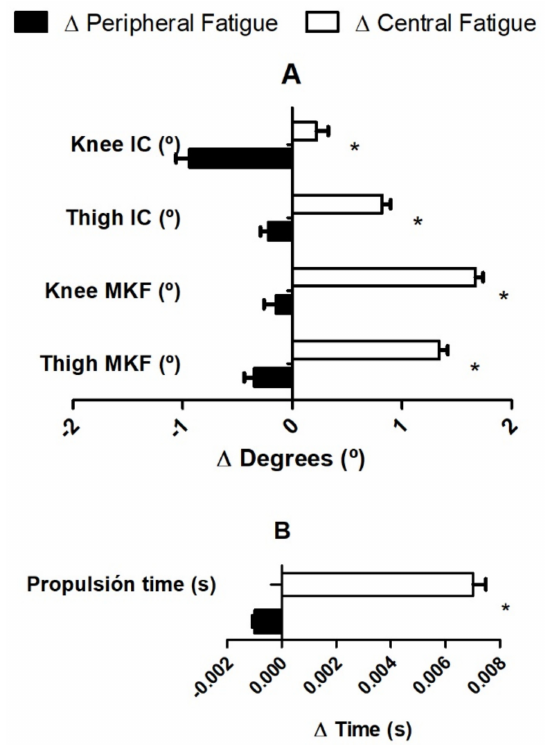
Figure 4. Change results between central and peripheral protocols. ( A ): Angular kinematics difference changes after fatigue protocols; ( B ): spatiotemporal difference changes after fatigue protocols. Black bars: changes due to peripheral fatigue; white bars: changes due to central fatigue. *: Statistically differences ( p < 0.05) between pre and post